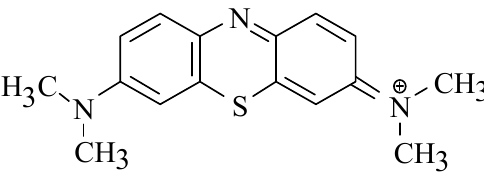
Figure 1. Chemical structure of Methylene Blue ion.